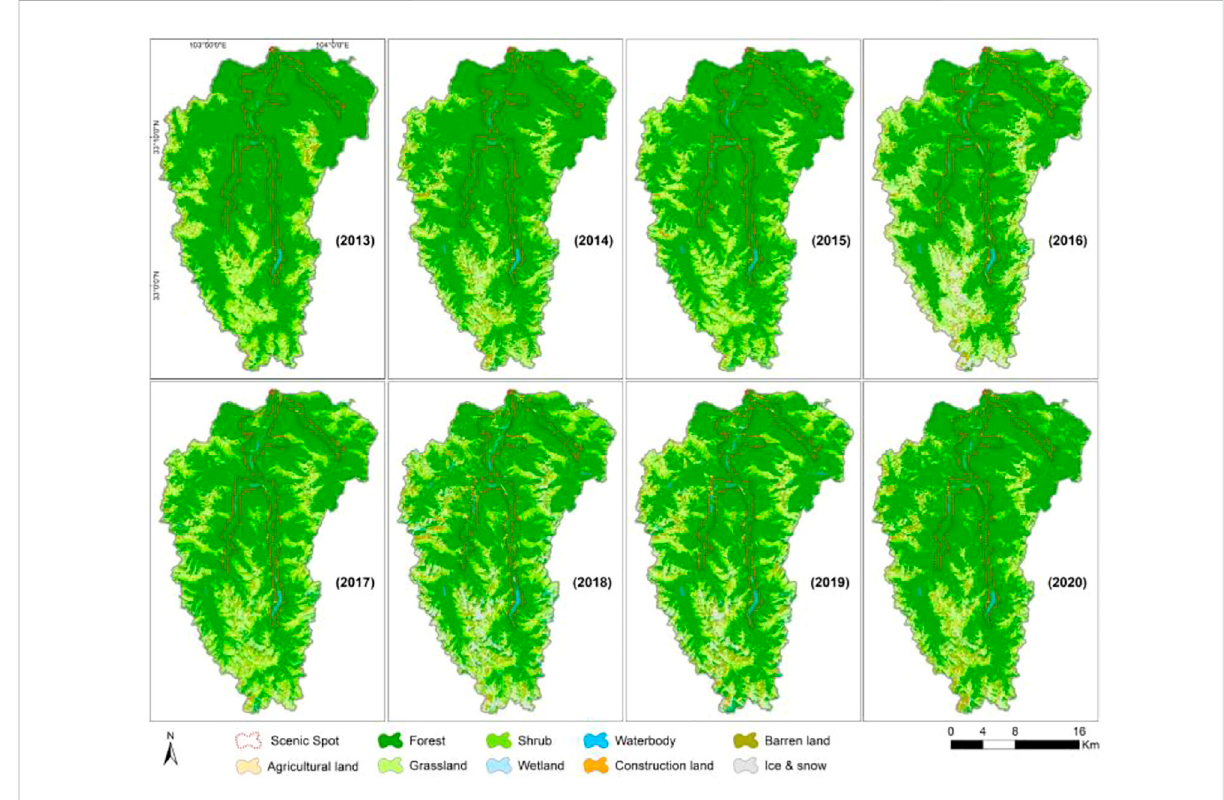
FIGURE 2 Spatio-temporal presentation of land cover in